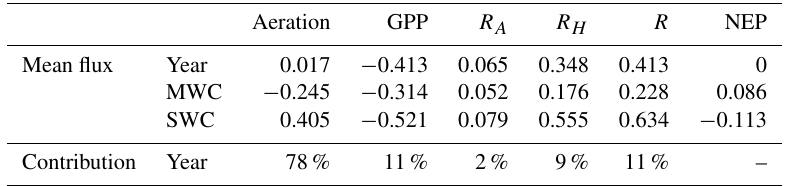
Table 3. Mean flux values (mmolm − 3 d − 1 ) and the contribution of each process to the DIC variations for the reference simulation over the year and SWC/MWC